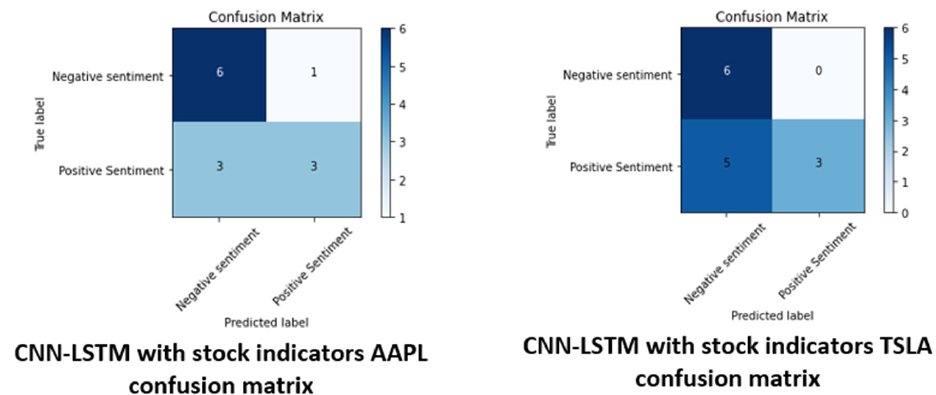
Figure 15. Confusion matrices with the best results.